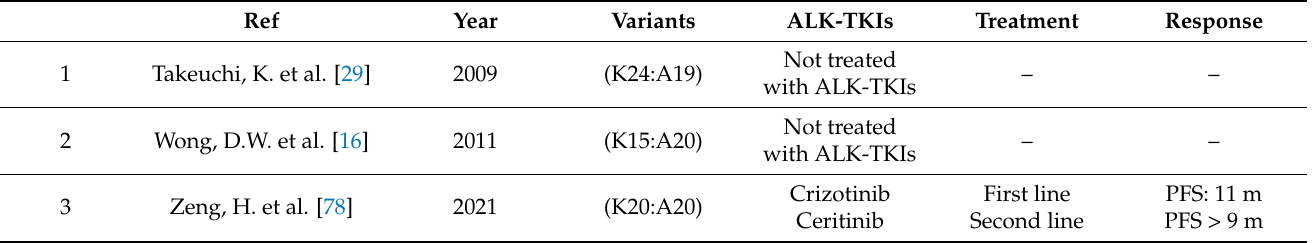
Table 2. Published details of KIF5B-ALK-positive NSCLC patients treated with